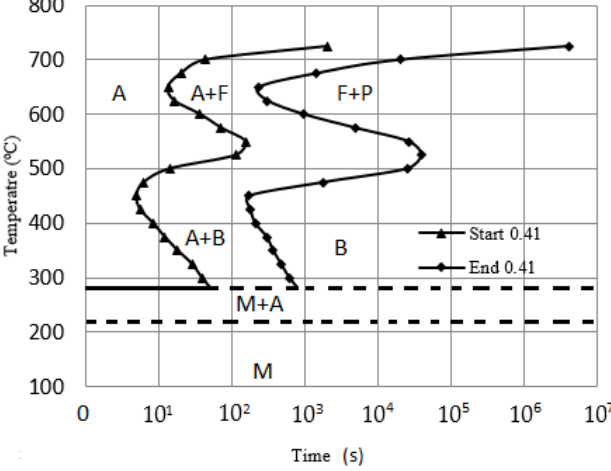
Figure 4. Time Temperature Transformation (TTT) diagram of AISI 1045 steel [9]